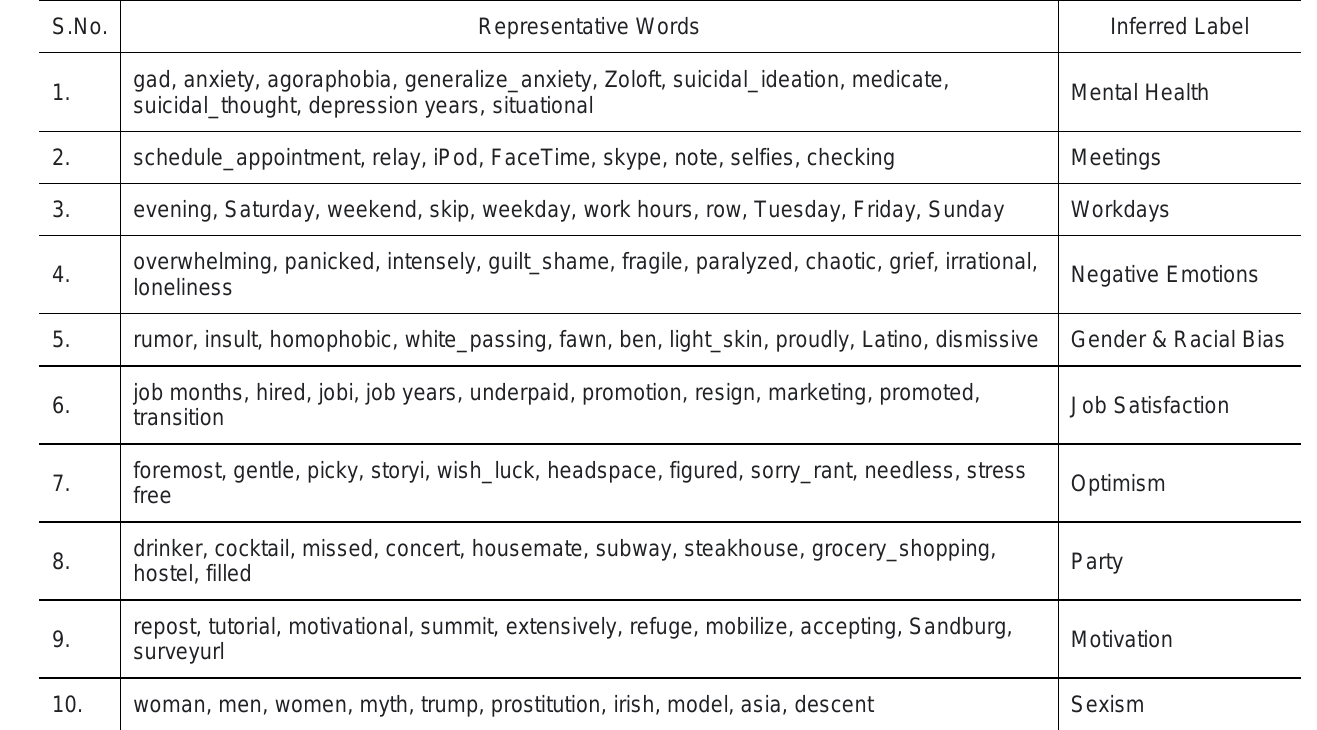
Table 2. List of aspects for Reddit posts, with top representative words for each aspect. Inferred aspect labels were assigned manually.